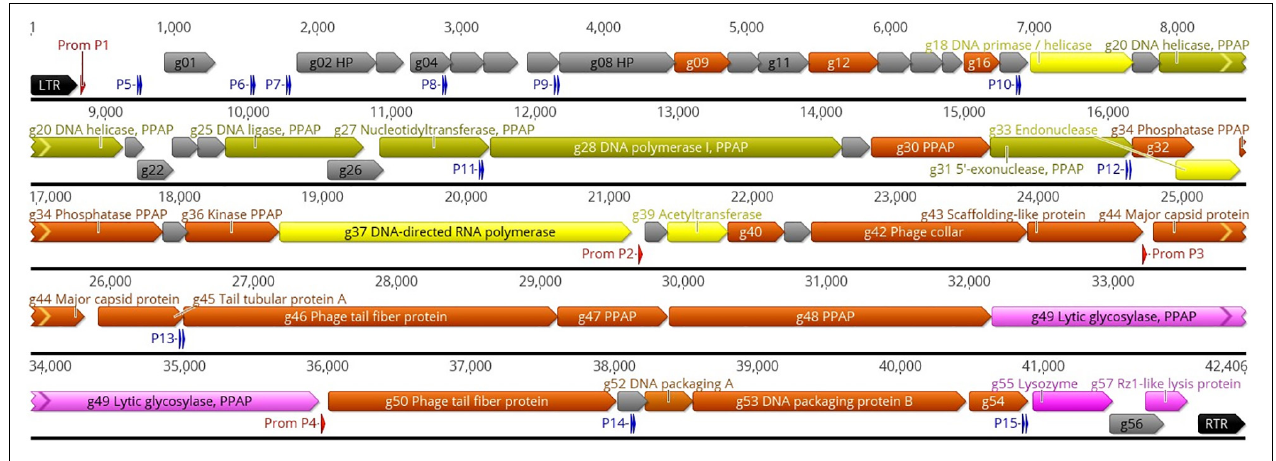
FIGURE 1 | Genomic map of phage φ 80-18. The nucleotide sequence of the phage is represented by the black horizontal line, above which are indicated the left and right terminal repeats (LTR and RTR, respectively) as black arrows, the phage RNAP promoters as red arrows, and the sigma-70 host RNAP promoters as blue double arrows representing the -35 and -10 boxes. The promoters are numbered and detailed information of them is given in Supplementary Table S3 . All the predicted genes are indicated by different-colored arrows and the gene names and predicted functions are indicated either inside or outside the arrows. The genes encoding hypothetical proteins (HP) are gray. The genes encoding phage particle-associated proteins (PPAP) are dirty green (for genes predicted to encode enzymes) and brown (for genes encoding predicted structural proteins). The genes predicted to encode phage particle-associated lytic glycosylase, and the lysozyme, are pink, and the genes predicted to encode DNA primase, endonuclease and RNA polymerase are yellow. The map was produced using the Geneious 10.2.6 (www.geneious.com).